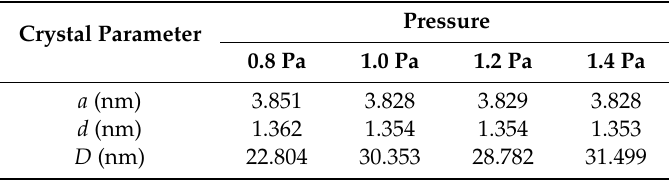
Table 1. Interplanar spacings, lattice constants, and grain sizes of MoS 2 films deposited by different pressures: d , interplanar spacing; a , lattice constant; and D , average grain size.